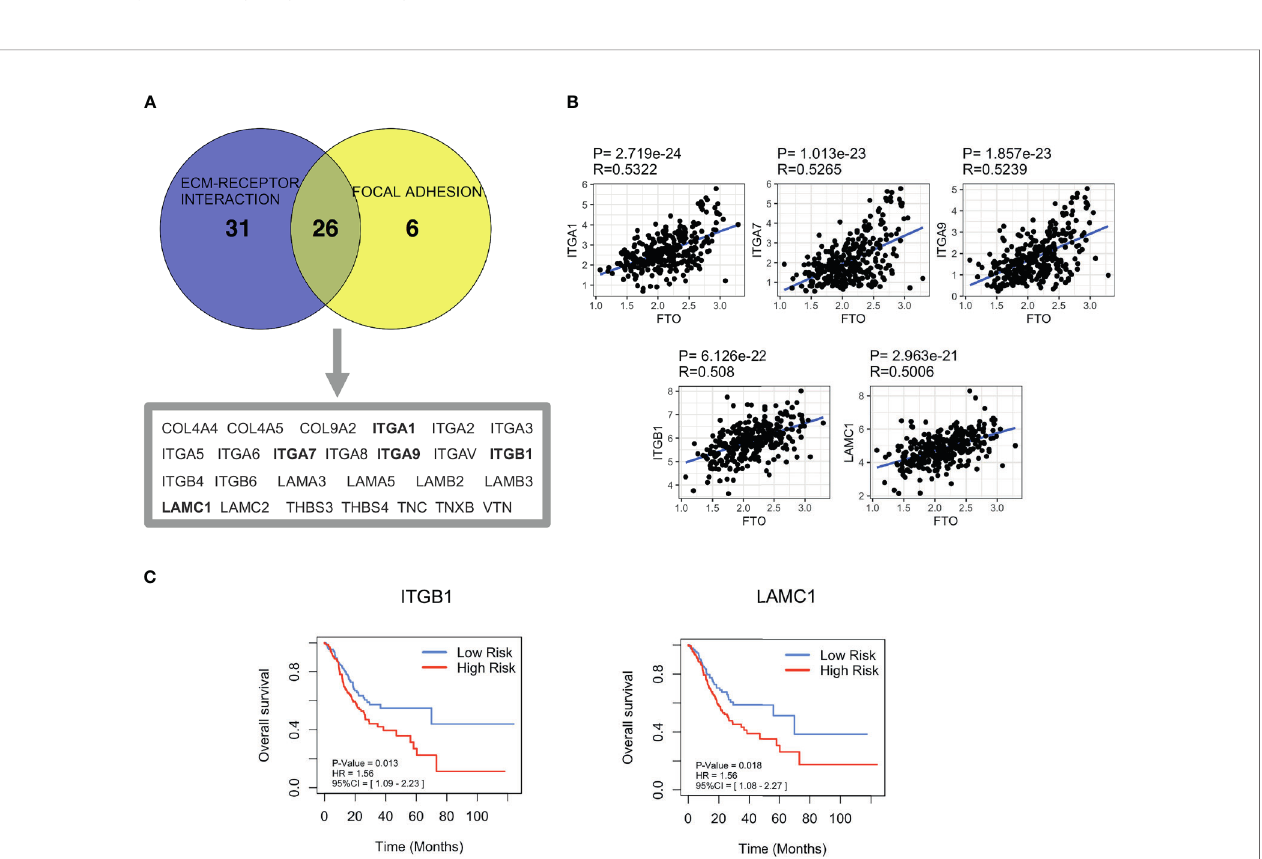
FIGURE 5 | Screening of FTO demethylated target genes involved in GC metastasis. (A) The coexpression genes in “ FOCAL ADHESION (FA) ” and “ ECM- RECEPTOR INTERACTION ” pathways were screened by Venn diagram analysis. (B) The correlation between the expression of the top fi ve coexpression genes and FTO was based on TCGA dataset. (C) Overall Survival (OS) of ITGB1 and LAMC1 in TCGA dataset was analyzed by Kaplan – Meier analysis.